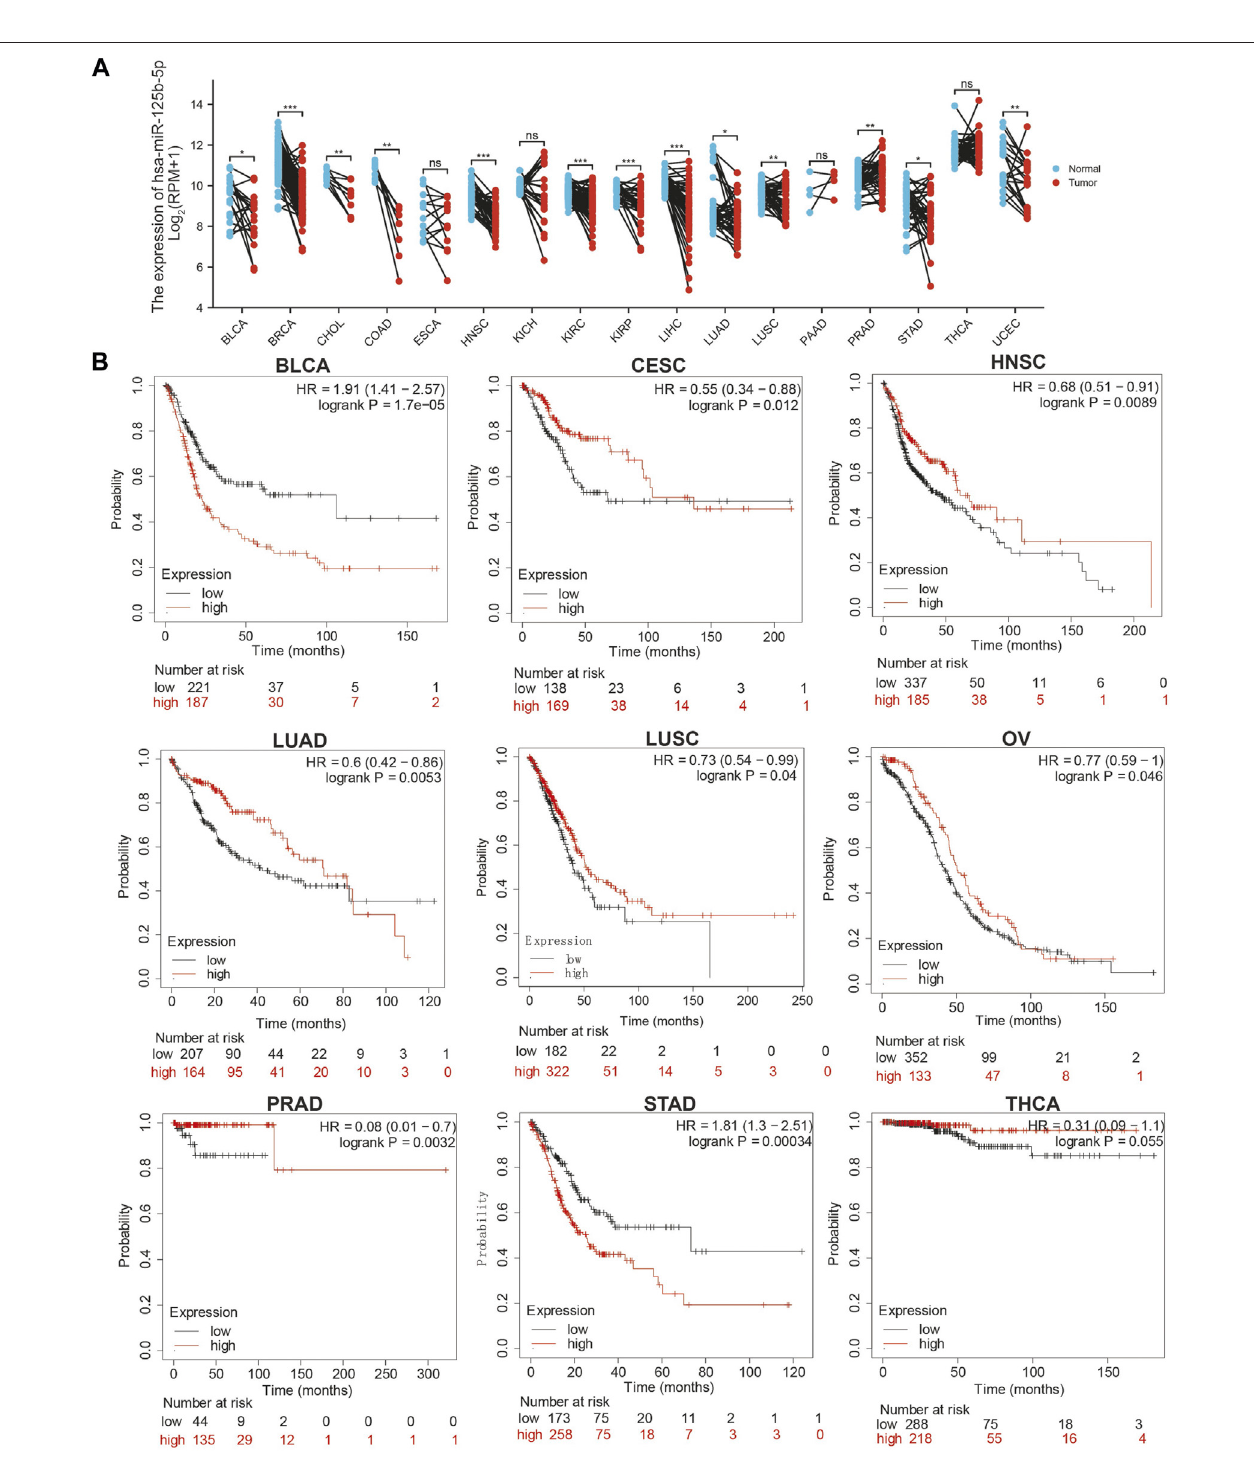
FIGURE 1 | Expression analysis for miR-125b-5p in human cancers. (A) Expression of miR-125b-5p in pan-cancer. (B) Prognosis of miR-125b-5p in pan-cancer examined using the Kaplan – Meier plotter database.